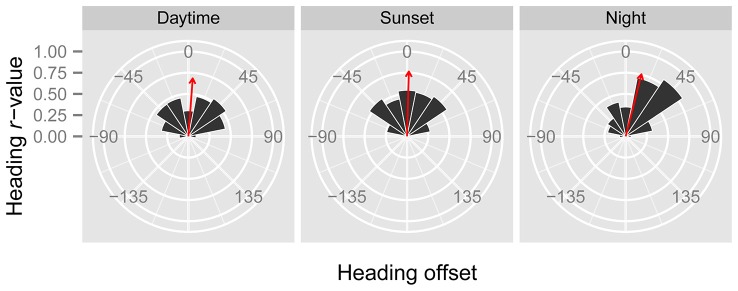
Circular histograms of the offsets between the mean headings and the mean displacements of “migration events” during the three time periods. Heading offsets to the right of the displacement have a positive value, while heading offsets to the left of the displacement have a negative value. The area of the black segments is proportional to the number of occasions when offsets fell within each 22.5° bin. The bearing of the red arrow indicates the mean offset of the entire dataset, while its length is proportional to the clustering of the dataset around the mean.